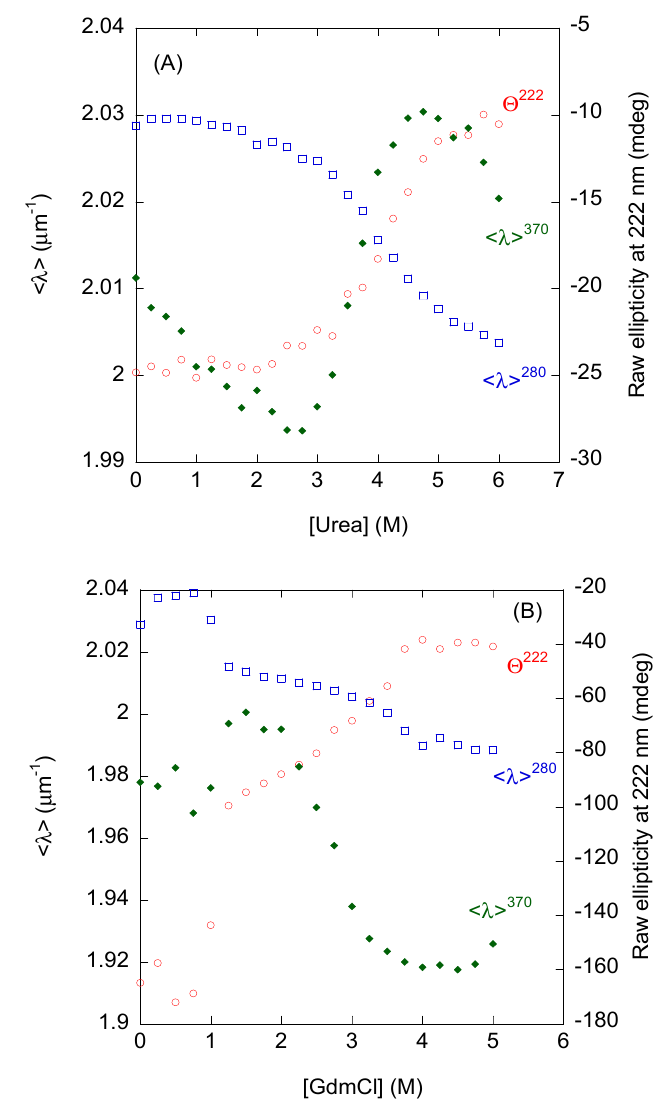
Figure 4. Chemical denaturations of bsHPrK/P followed by spectroscopic techniques: ( A ) Urea denaturations followed by the intrinsic fluorescence monitored by the < λ >, after excitation at 280 nm (< λ > 280 ); by ANS fluorescence monitored by the < λ > (both on the left axis) (< λ > 370 ); the raw ellipticity at 222 nm ( Θ 222 ) (right axis). The values of < λ > 280 were scaled (by a factor of 1.44) to allow for a comparison with those of ANS. ( B ) GdmCl denaturations followed by the intrinsic fluorescence monitored by the < λ >, after excitation at 280 nm (< λ > 280 ); by the ANS fluorescence monitored by the < λ > (both on the left axis) (< λ > 370 ); the raw ellipticity at 222 nm ( Θ 222 ) (right axis). Protein concentration used in the GdmCl experiments followed by CD and fluorescence was 12.6 µ